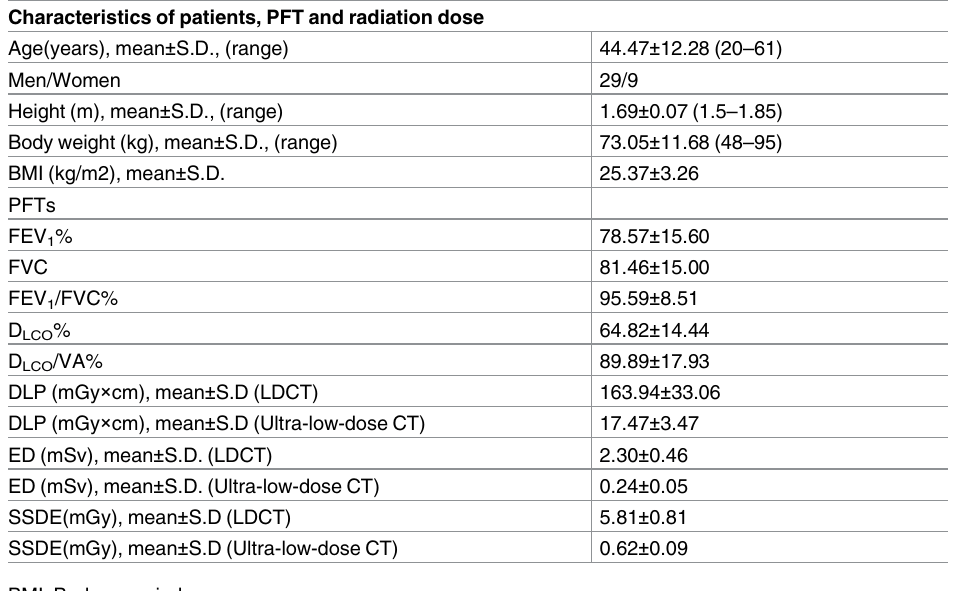
Table 1. Patient clinical characteristics and radiation dose. Characteristics of patients, PFT and radiation dose Age(years), mean ± S.D.,